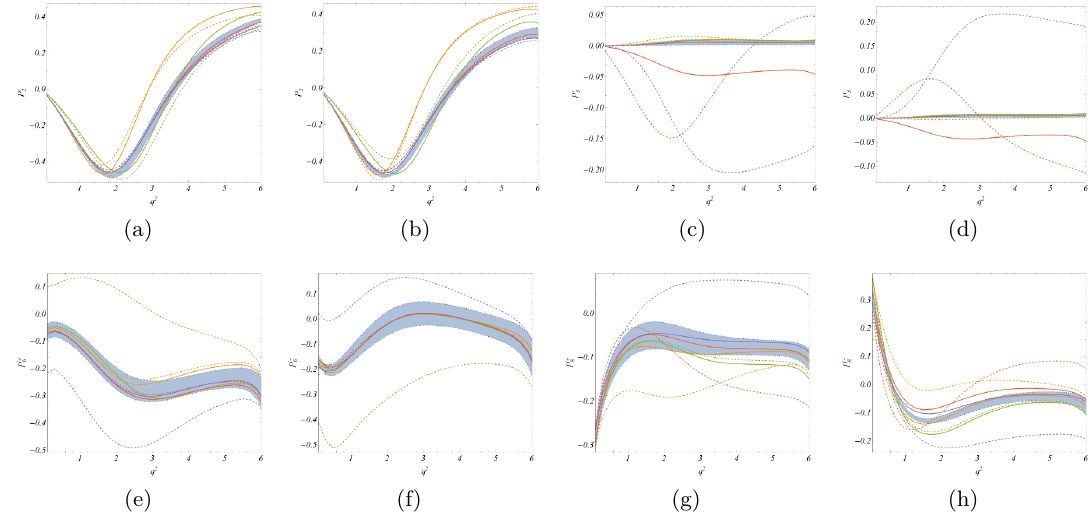
Figure 3 . The study of the q 2 dependencies of a few tagged observables in B + → ρ + ll and B − → ρ − ll decays, which are measurable at both the LHCb and Belle. The caption will be similar to the one given in figure 2; also, we follow the legends of that figure.